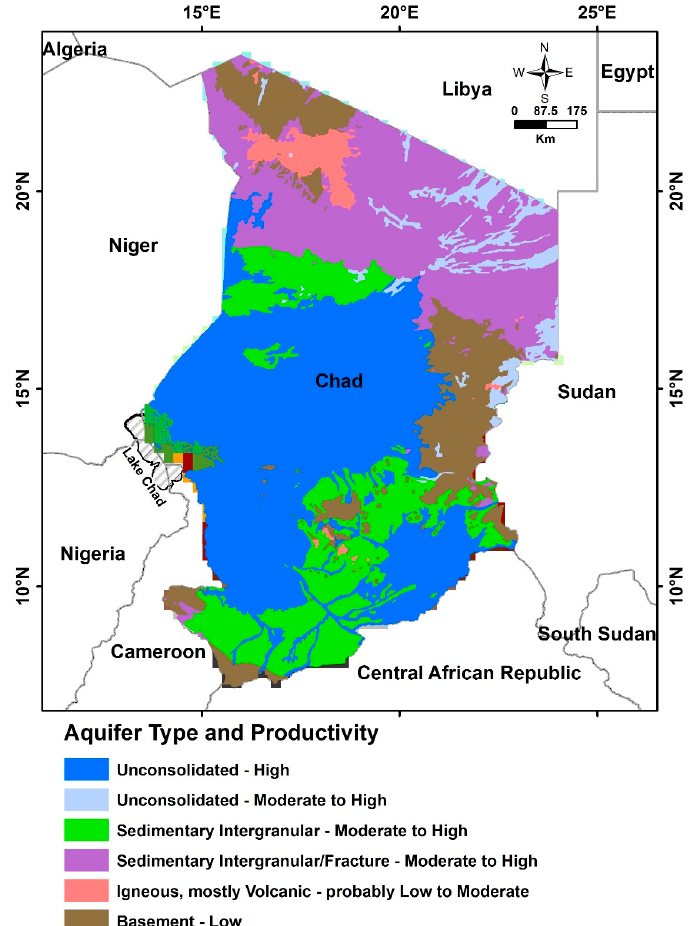
Figure 2. Aquifer type and productivity of the study area.